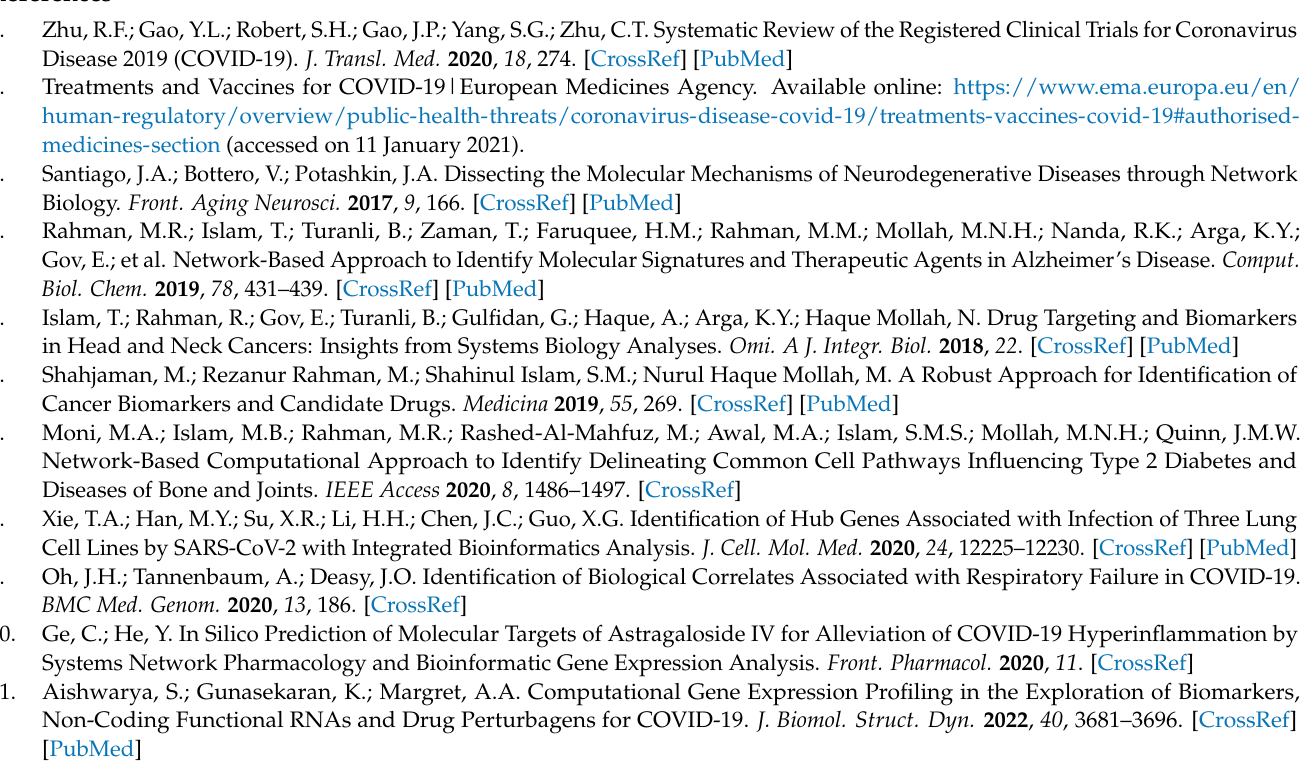
Supplementary File S3: Molecular docking scores of top 11 published hub-DEGs and the 145 drug elements.; Supplementary Figure S1: Docking poses of the proposed 10 ligands with the proposed top ordered 6 targets (a) MAPK1, (b) EGFR, (c) CXCL8, (d) STAT3, € UBC7, and (f) TP53.; Supplemen- tary Figure S2: Docking poses of the proposed 10 ligands with the previously published top ordered 4 targets (uncommon) (a) NFKBIA, (b) IRF7, (c) MX1, and (d) CASP3.; Supplementary Figure S3: Survival curve analysis of the proposed